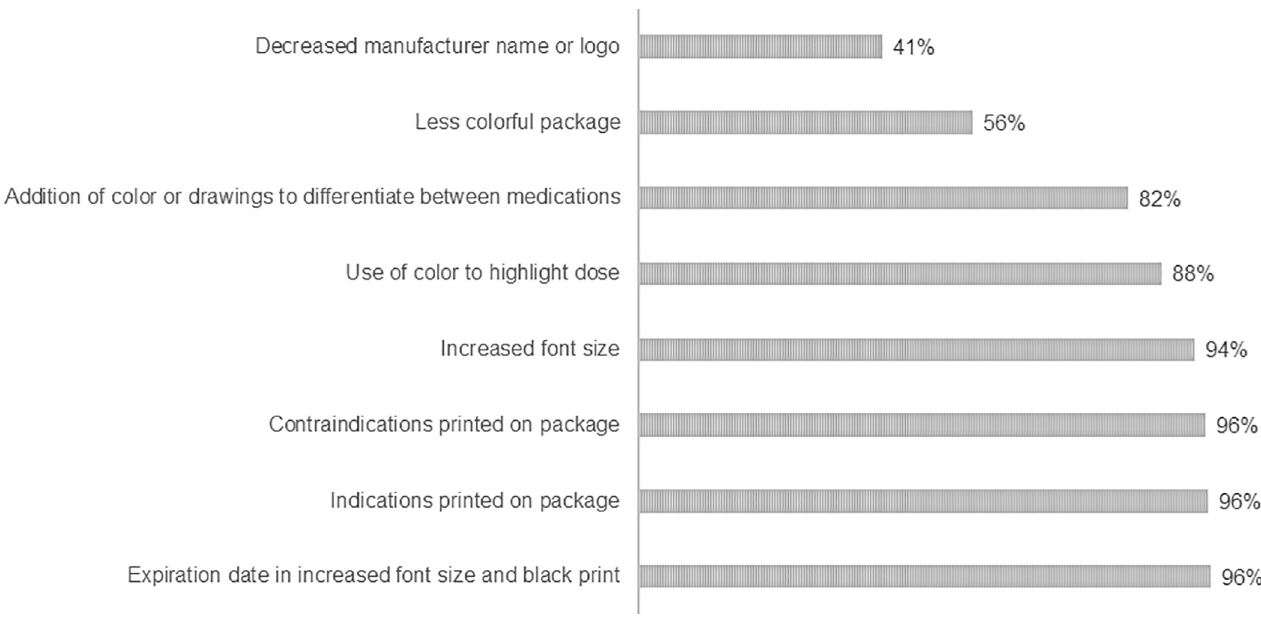
Fig 4. Users’ acceptance of possible label improvements. (n =